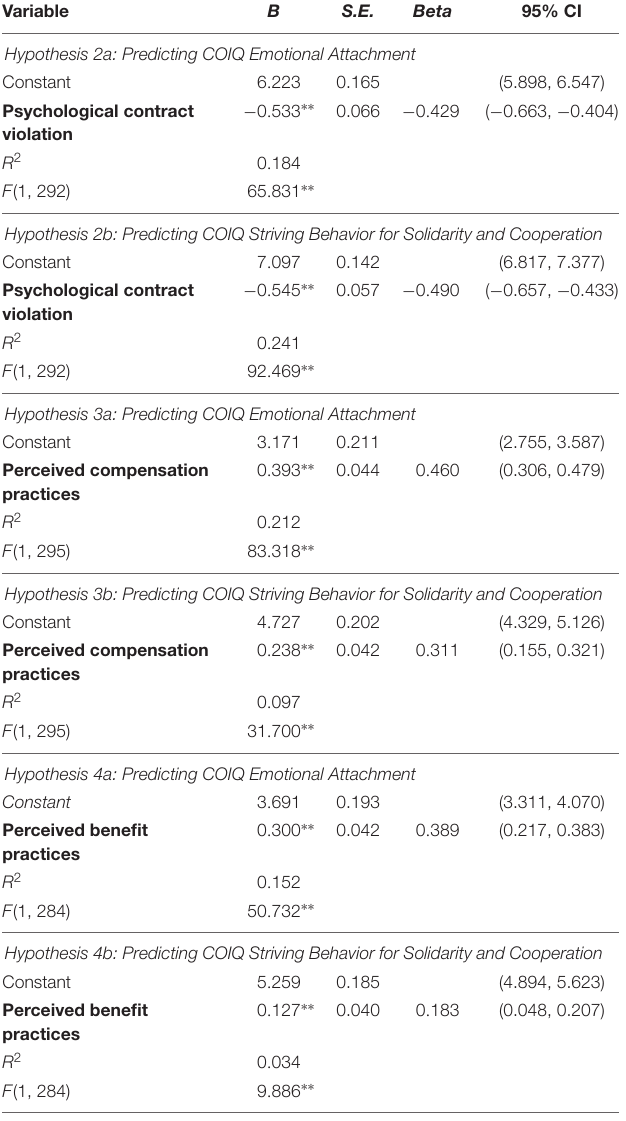
TABLE 7 | Hypothesis testing: predictors of the COIQ dimensions (Study 2). TABLE 8 | The COIQ dimensions predicting unethical pro-organizational behavior ( Hypothesis 5 , Study